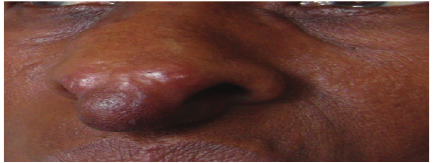
Figure 1: Nodule on the nose (Picture of Dr. Kouassi yao Isidore, CHU Treichville).